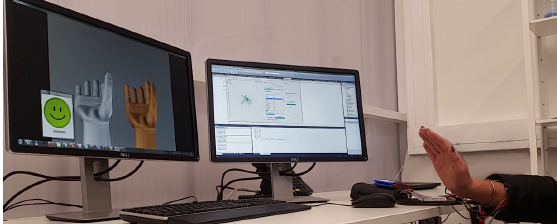
Figure 5. Testing part of the experiment: the participant imitates the grey animated hand model and controls the skin-colored model. The green smiling face indicates a successful